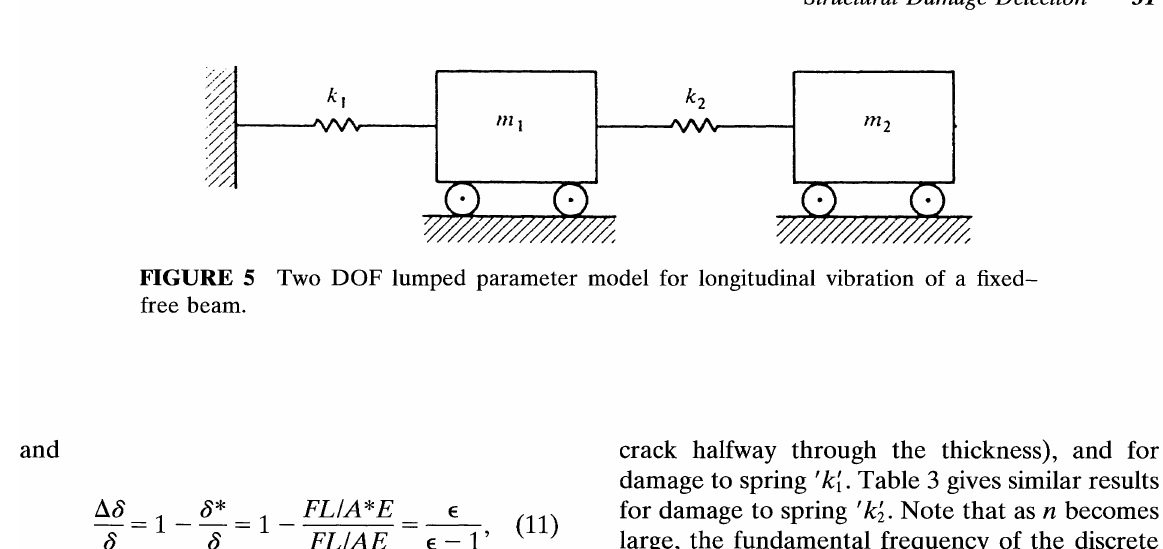
FIGURE 5 Two DOF lumped parameter model for longitudinal vibration of a fixed free beam.